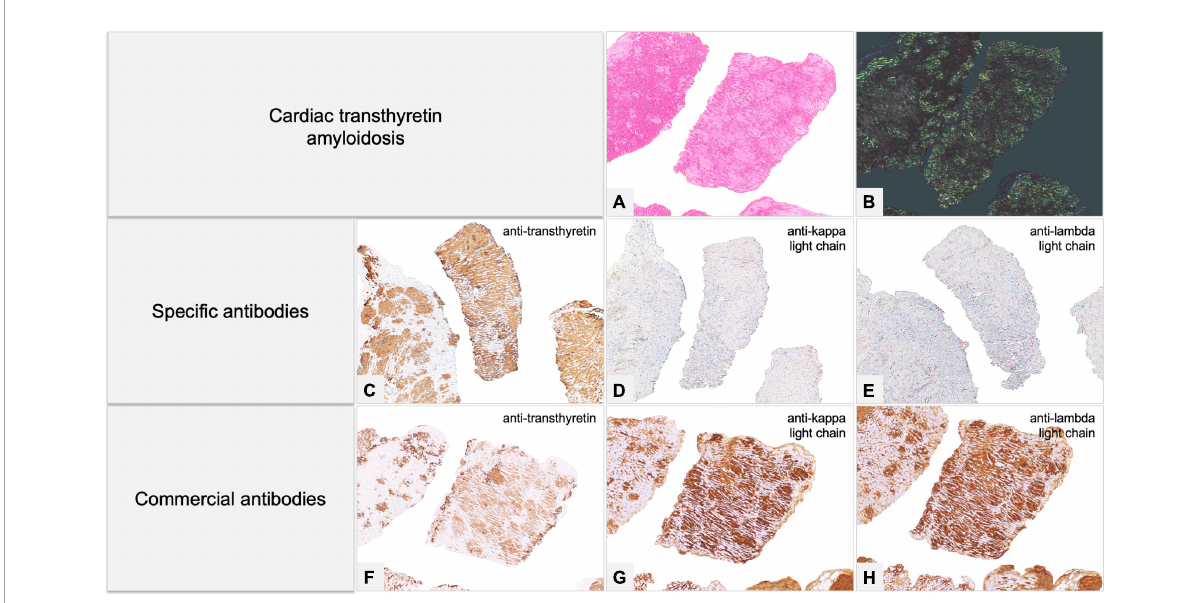
FIGURE8 Endomyocardial biopsy of a 68-year-old male patient, performed for suspected cardiac amyloidosis in absence of hematological disease. (A,B) Histology shows extensive amyloid deposits involving myocardial interstitium, with a prevalent nodular pattern, and the vessels. (C–E) Immunohistochemistry with specific antibodies clearly favored an ATTR form, as it showed diffuse homogeneous immunostaining for TTR (C) and negativity for anti-kappa (D) and anti-lambda (E) immunoglobulin light chains. The result was confirmed by proteomics with mass spectrometry in tandem mode, which was positive for TTR proteotypic peptides. (F–H) Immunohistochemistry with commercial antibodies, however, showed weak immunostaining for TTR (F) and strong, diffuse positivity using anti-kappa (G) and anti-lambda (H) light chains. Genotyping allowed diagnosis of ATTRwt. (A) Hematoxylin-Eosin 50 × . (B) Congo red under polarized light, 50 × . Specific antibodies (amY-kit reduced PeloBiotech): (C) Anti-ATTR-TIE (50 × ). (D) Anti-kappa-KRA/KUN (50 × ). (E) Anti-lambda-UTI/LAT (50 × ). Commercial antibodies against native proteins. (F) Anti-ATTR AbCam clone EP2929Y (50 × ). (G) Anti-kappa Roche-Ventana (50 × ). (H) Anti-lambda Roche-Ventana (50 ×